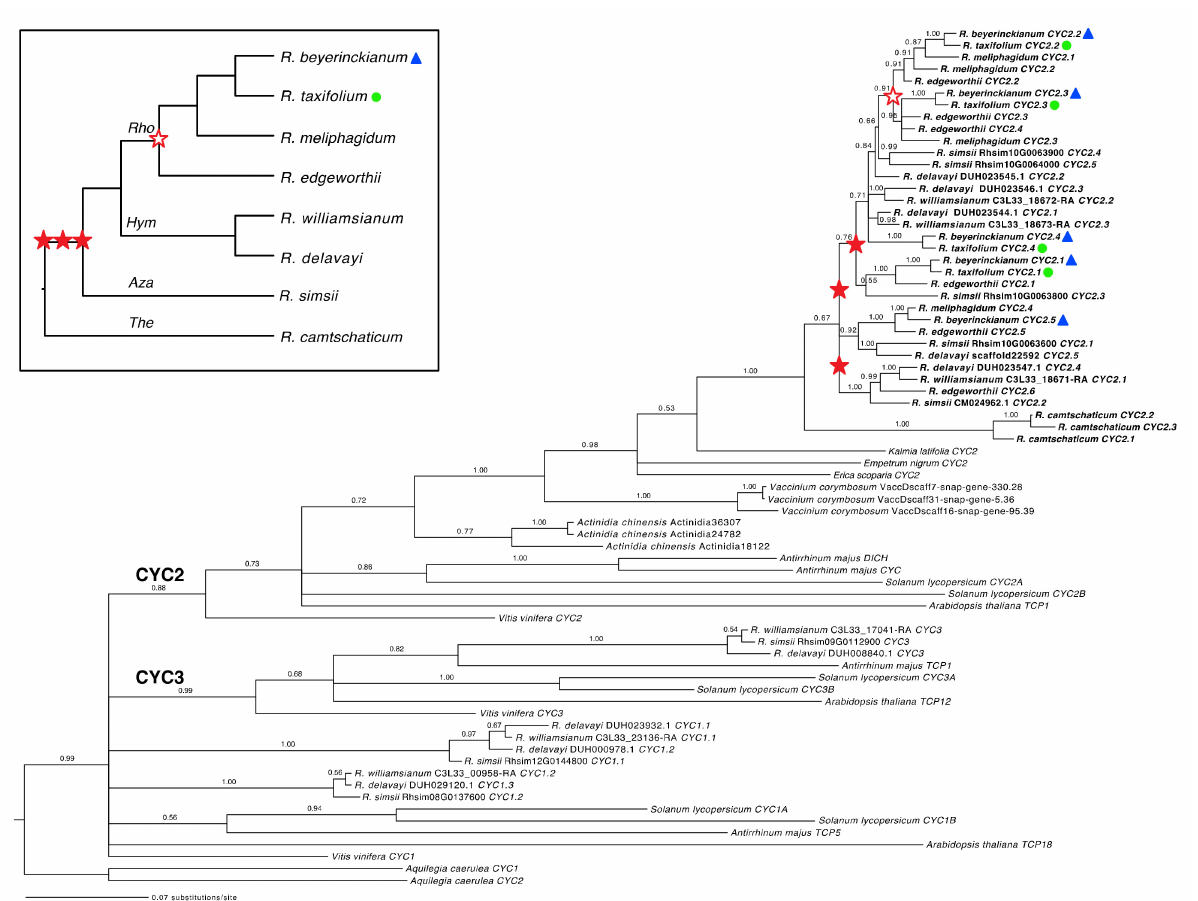
Figure 2. Evolution of CYCLOIDEA ( CYC ) homologs in Rhododendron (Ericaceae) and outgroups. Reconstructed Bayesian CYC phylogeny with posterior probabilities at all nodes. Three gene duplications in the CYC2 lineage that are shared by subgenera Azaleastrum, Hymenanthes , and Rhododendron , indicated by filled red stars, occurred in Rhododendron history after its divergence from R. camtschaticum . A subsequent lineage-specific duplication in subgenus Rhododendron is indicated by an empty red star. Experimental species are highlighted with a blue triangle (bilateral symmetry) and green circle (radial symmetry). Inset shows sampled Rhododendron taxa in phylogenetic context, based on prior studies [44,45,55]. Aza = subg. Azaleastrum , Hym = subg. Hymenanthes , Rho = subg. Rhododendron , and The = subg. Therorhodion